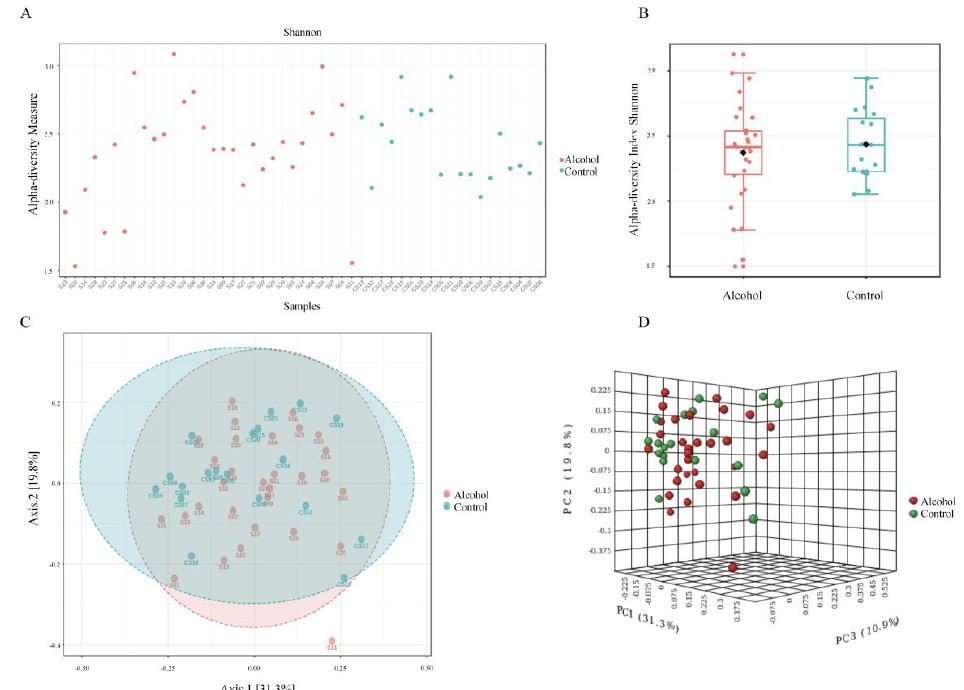
Figure 4. Alpha and beta diversity profiling and significance testing. The Shannon alpha-diversity analysis at genus level was performed in filtered data input by using Mann–Whitney / Kruskal–Wallis statistical method. The samples ( A ) or the groups ( B ) were represented on x -axis and their estimated diversity on y -axis. Each sample or boxplot are colored based on alcohol consumption status (alcohol users = red, control = blue). The beta-diversity analysis at genus level by using the non-phylogenetic Bray – Curtis index distance method was using to stablish the changes in abundance of taxa present in the dataset. Principle coordinate analysis (PCoA) was used to visualize these matrixes in 2 ( C ) or 3-D plot ( D ). Each point in the graph (alcohol users = red, control = green) represents the entire microbiome analyses of a single sample. The statistical significance of the clustering pattern was evaluated by using Permutational MANOVA (PERMANOVA).